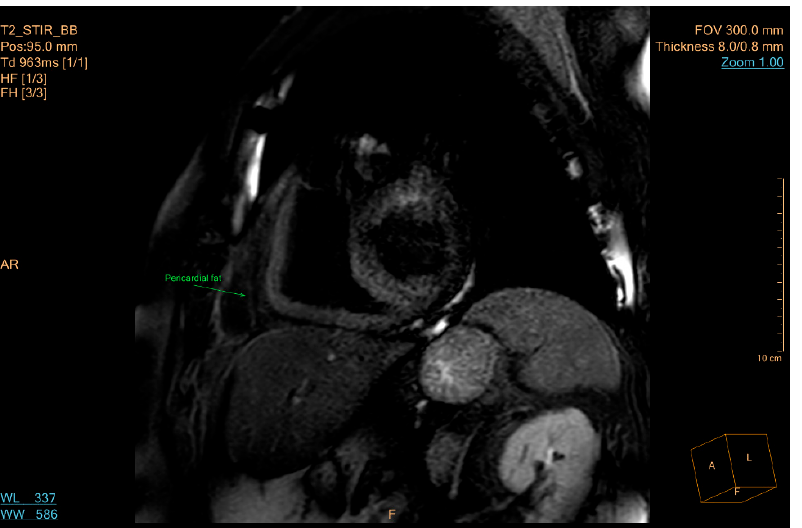
Figure 11. Cardiac MRI Philips Ingenia 3Tardiac T2-STIR sequence, short-axis view, 8 mm, showing hypointensity lateral of right ventricle signifying adipose tissue. Prepared by the authors. Courtesy of the Pediatric Clinical Hospital Sibiu, Lucian Blaga University of Sibiu.